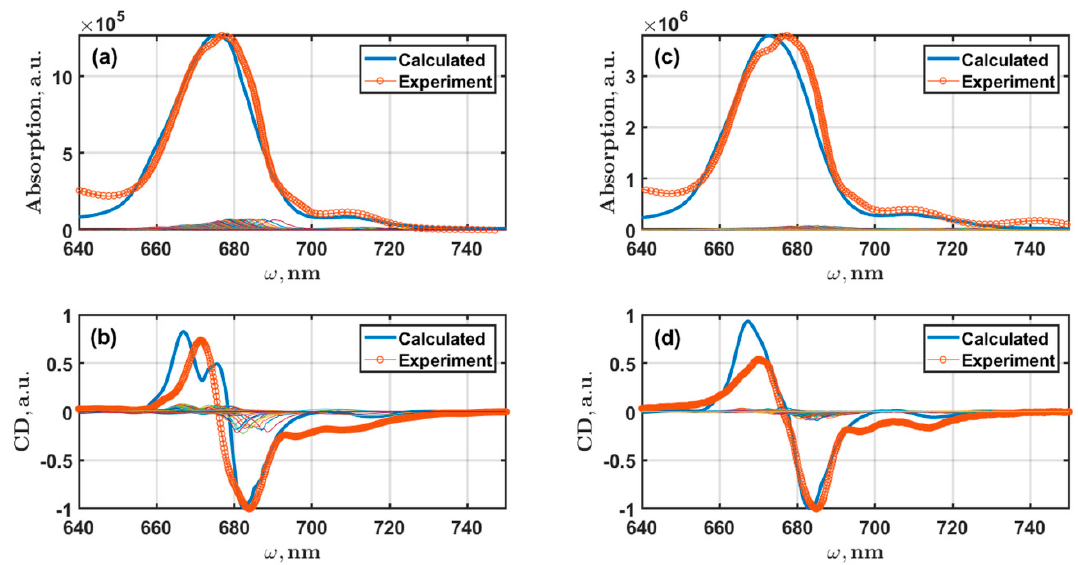
Figure 5. Calculated exciton absorption (upper plots) and CD (lower plots) spectra for PSI monomers ( a , b ) and trimers ( c , d ). The experimental absorption spectra measured at 4 K; CD spectra measured at 77 K. The absorption and CD spectra were modeled for the corresponding temperatures. FWHM of inhomogeneous broadening is 200 cm − 1 . All data averaged over 1500 realizations of the Monte Carlo method. The thin colored lines are the intensities of exciton states.